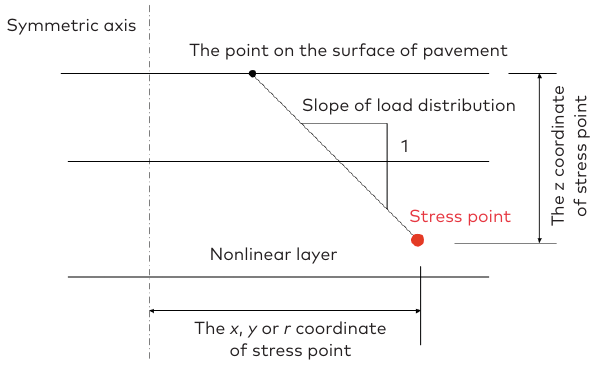
Figure 4. The location of the stress point (Huang,